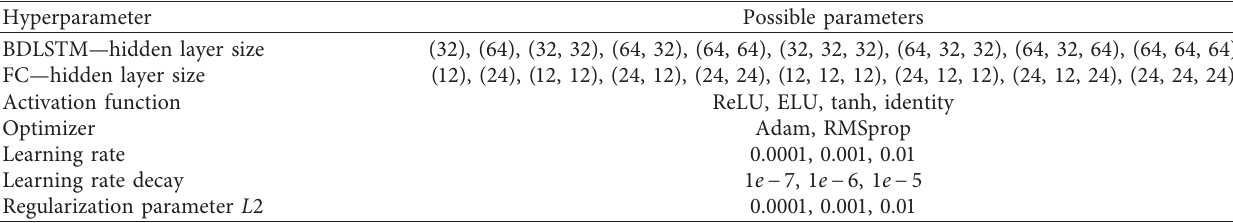
Figure 4: The architecture of an unfolded BDLSTM with three steps ( x : input vector; h state for the negative direction; σ : function used to combine two output sequences; y : output Table 3: Hyperparameter values used in the model training process. The first column represents hyperparameter name, and in the second column, possible parameters are shown. Hyperparameter